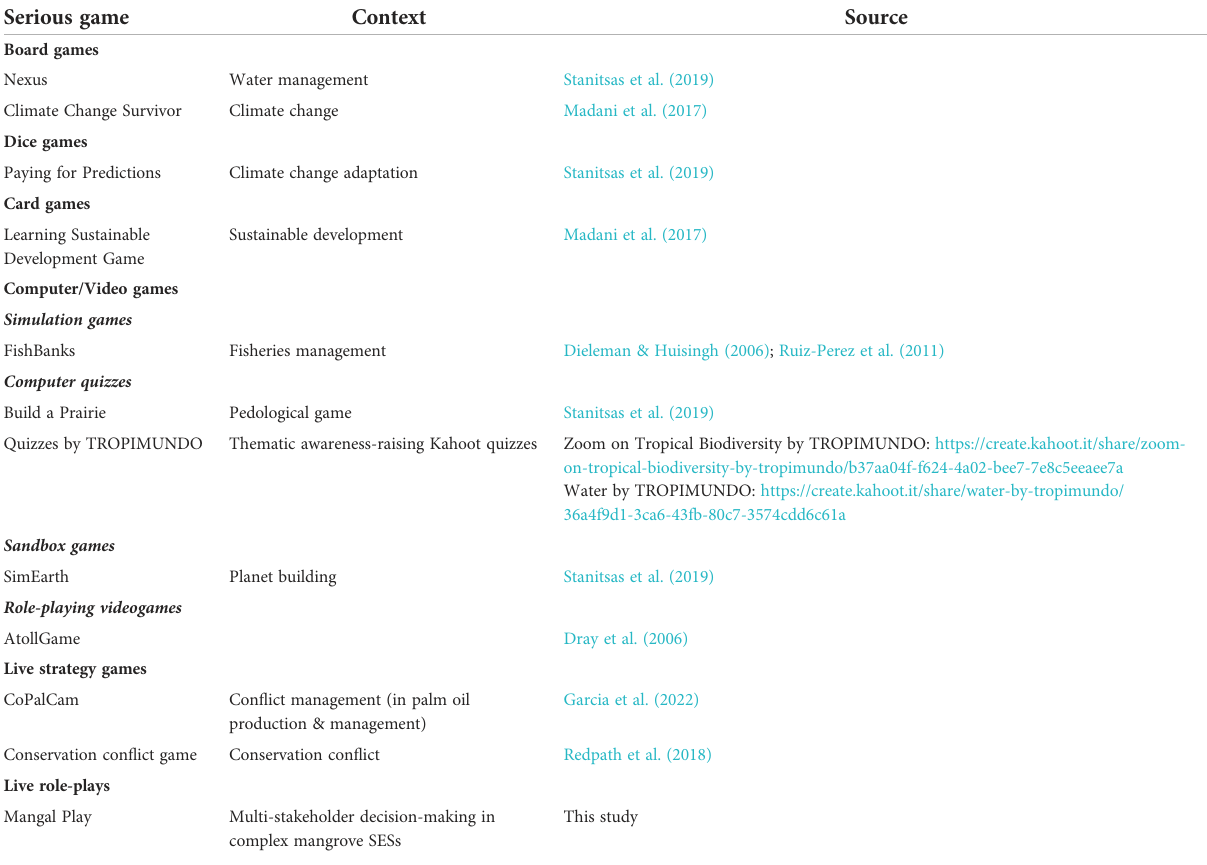
TABLE 1 Selection of serious games/role plays used in environmental management and biodiversity conservation, to illustrate the diversity of contexts in which these games are